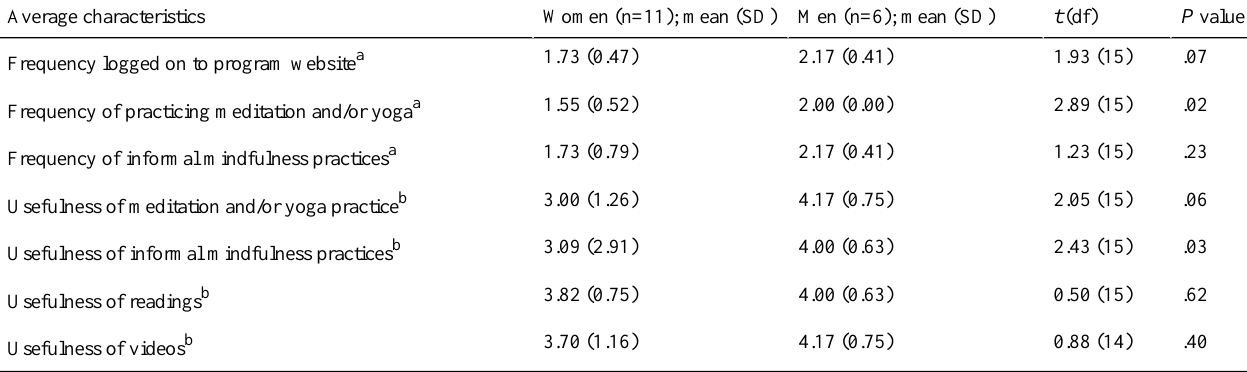
Table 2. Average type, frequency, and usefulness of participation in online mindfulness-based stress reduction in lesbian, gay, and bisexual women and men, per